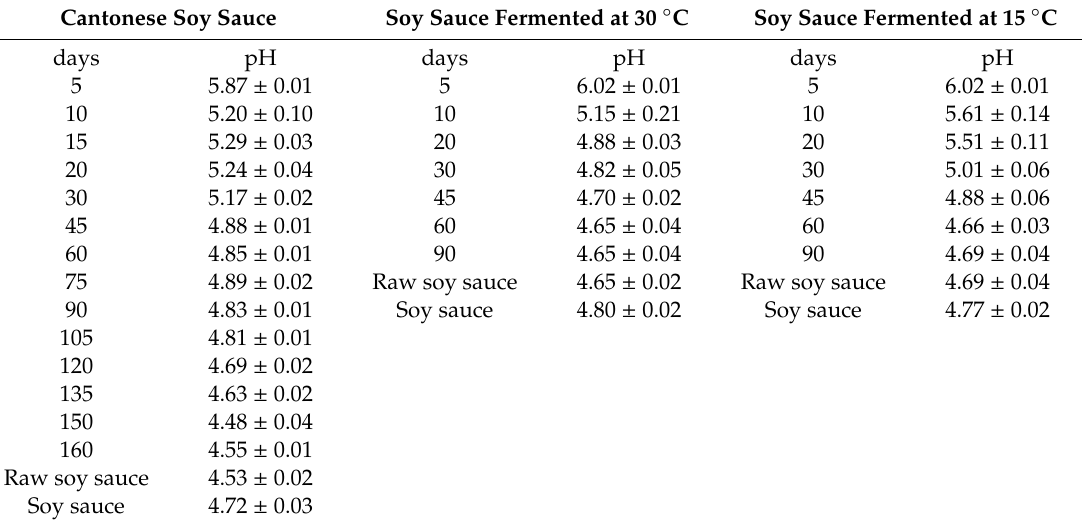
Table 1. pH in three kinds of soy sauce during fermentation stage.